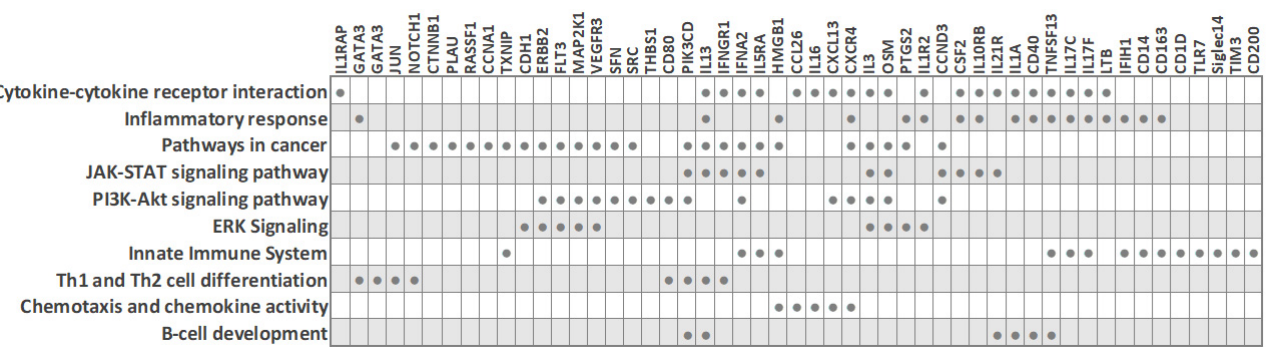
Figure 3. Biological processes and transcripts significantly deregulated in peripheral blood cells of TNBC patients compared to other BC subtypes (based on PBC transcriptome studies). The filled circles mark the transcripts that are differentially expressed in TNBC.